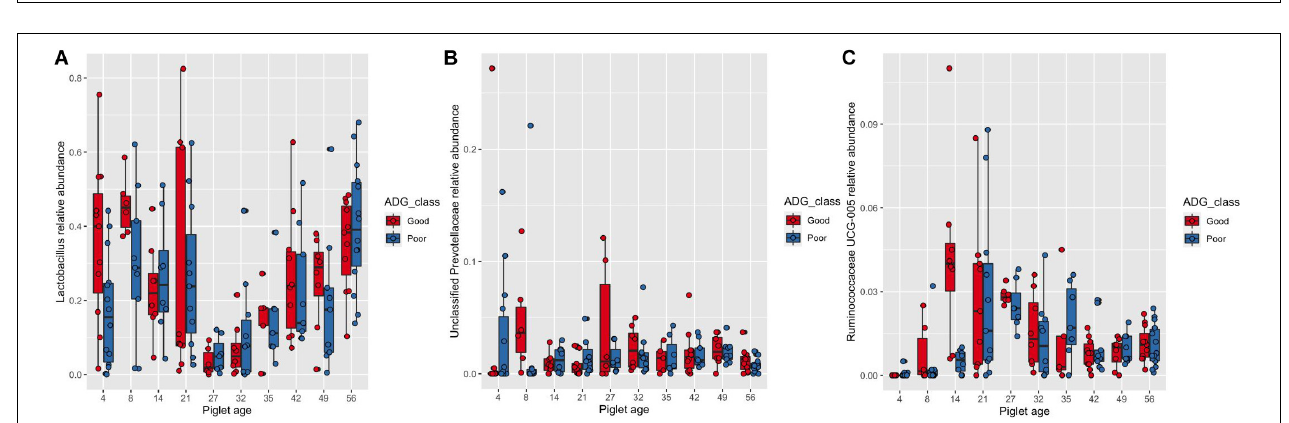
FIGURE 3 | Box and whisker plot demonstrating the changes in the abundance of (A) Lactobacillus, (B) unclassified Prevotellaceae and (C) Ruminococcaceae UCG-005 associated with piglet age and average daily gain class (Good or Poor). (A) Significant differences in Lactobacillus abundance associated with increasing piglet age and the interaction with average daily gain classes (Good or Poor). Significant differences due to the interaction are identified by differences in the assigned Tukey HSD letters: days 4Good de , 4Poor abc , 8Good e , 8Poor bcde , 14Good abcde , 14Poor bcde , 21Good abcde , 21Poor bcde , 27Good a , 27Poor abcd , 32Good abc , 32Poor ab , 35Good abcde , 35Poor abcde , 42Good cde , 42Poor abcde , 49Good abcde , 49Poor abcde , 56Good e and 56Poor e . (B) Significant differences in unclassified Prevotellaceae abundance associated with increasing piglet age and the interaction with average daily gain classes (Good or Poor). Significant differences due to the interaction are identified by differences in the assigned Tukey HSD letters: days 4Good a , 4Poor abc , 8Good c , 8Poor ab , 14Good abc , 14Poor abc , 21Good abc , 21Poor abc , 27Good abc , 27Poor abc , 32Good bc , 32Poor bc , 35Good abc , 35Poor abc , 42Good abc , 42Poor bc , 49Good abc , 49Poor c , 56Good abc and 56Poor abc